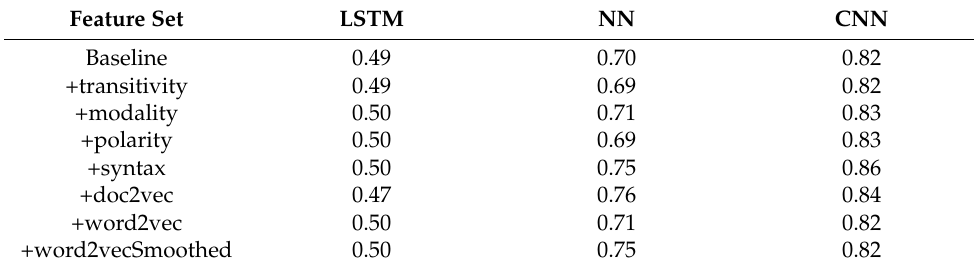
Table 5. Classification of problems from non-problems using deep learning networks by training data iteration.